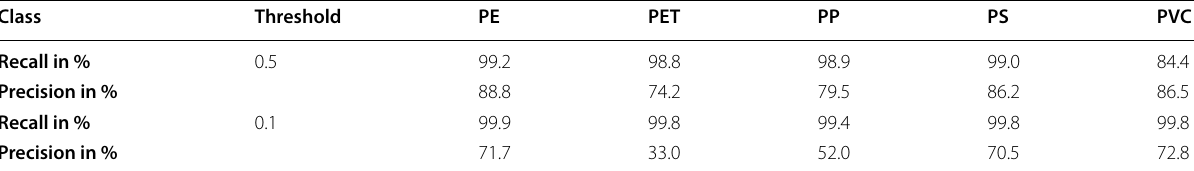
Table 4 Precision and recall of deep learning (one model per class)